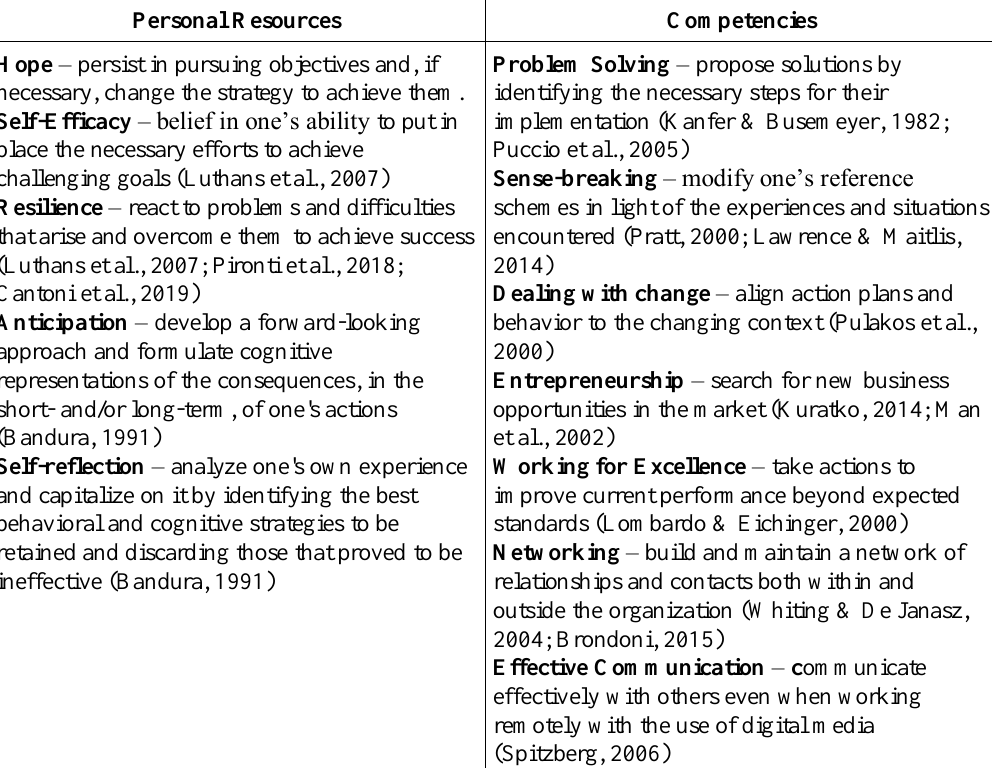
Table 2: Transversal Dimensions in the Context of an International Assignment Personal Resources